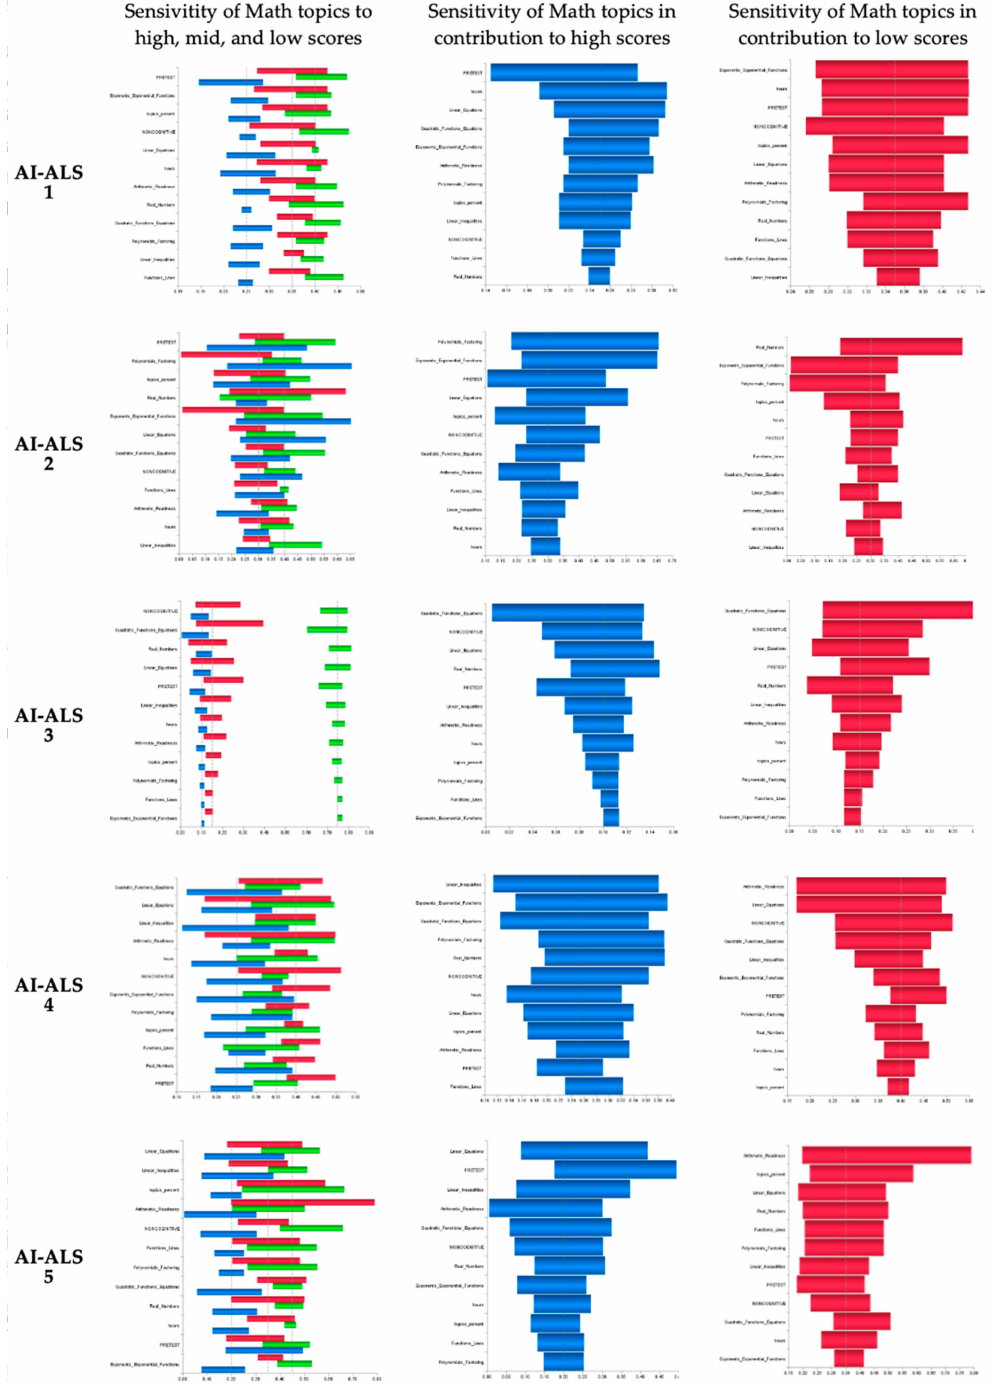
Figure 12. Visualizations of the sensitivity analysis data of the five groups of students in their respective AI-ALS, regarding how their learning progress of the mathematics topics within each AI-ALS could potentially a ff ect their outcomes in the paper-based